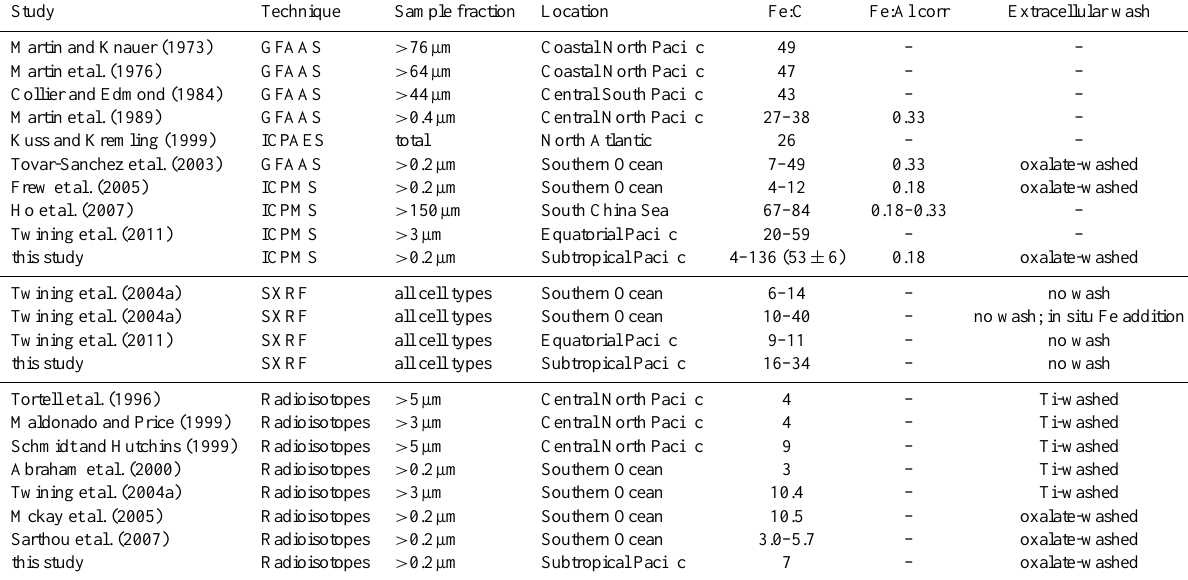
Table 6. Summary of previously published µmolFe:molC ratios including values from this study. Based on previously published compilation by Twining et al. (2004b). “Fe:Al corr” refers to the molar Fe:Al ratio used for lithogenic Fe corrections to Fe:C ratios. Fe:C ratios from Martin and Knauer (1973), Martin et al. (1976), and Collier and Edmond (1984) were previously cited by Bruland et al.